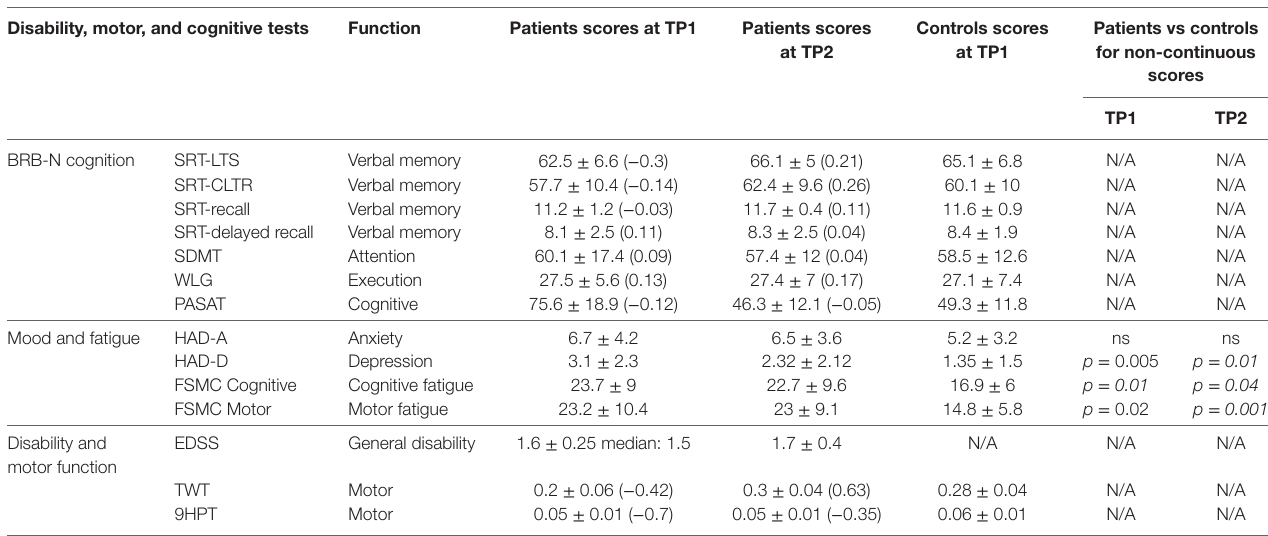
TaBle 2 | Clinical scores. Disability, motor, and cognitive tests Patients vs controls